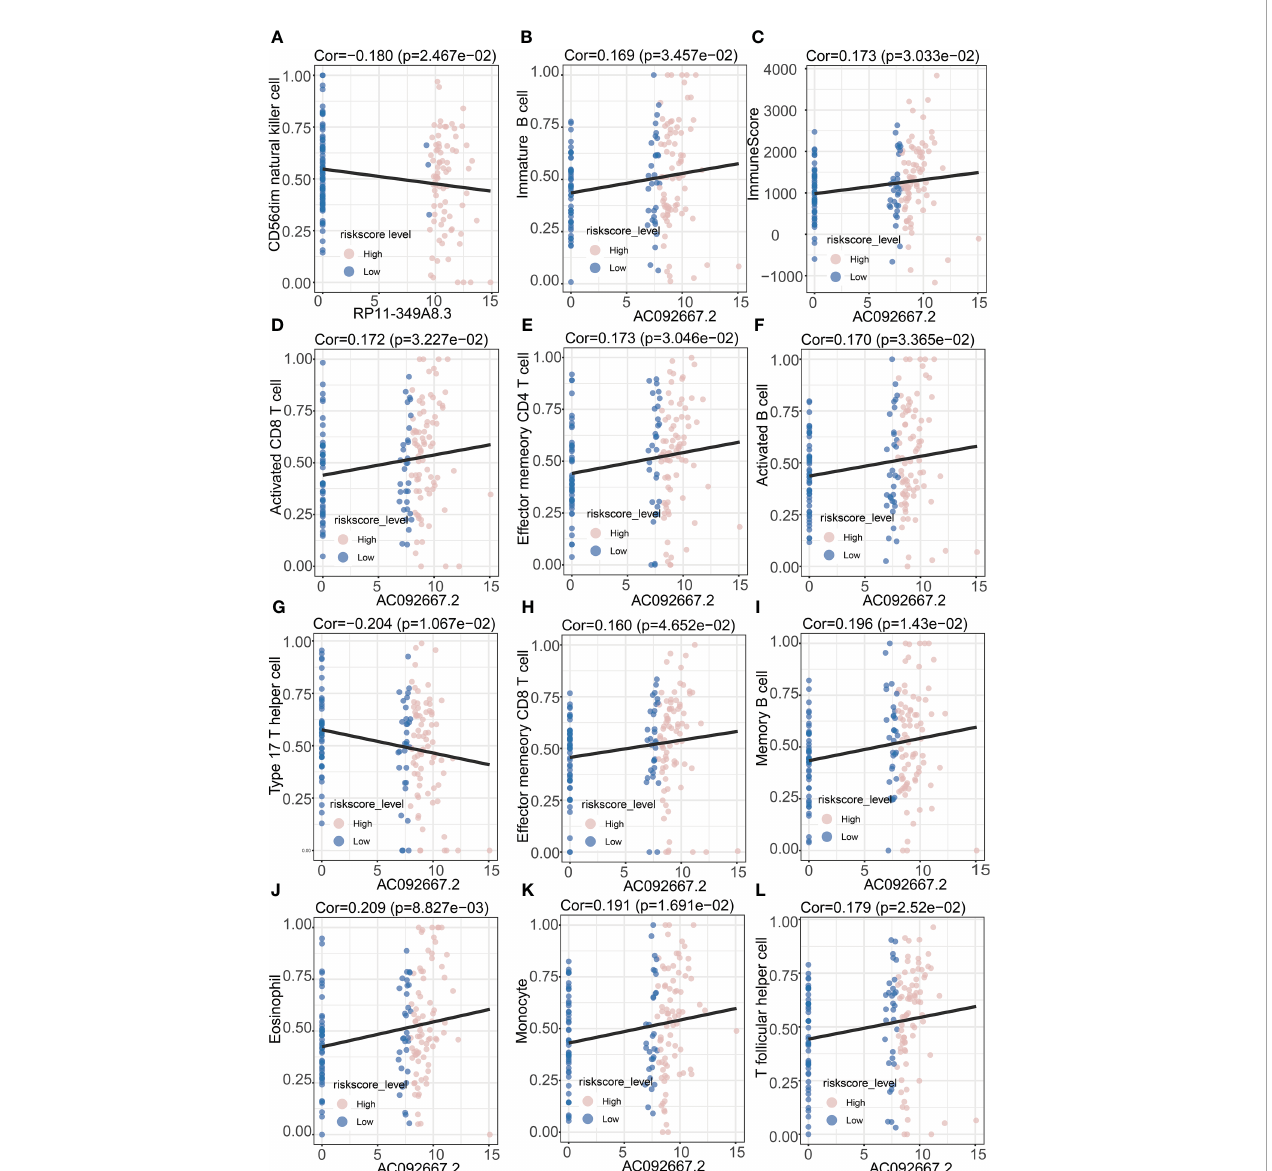
FIGURE 8 Correlation Analysis of prognosis-related lncRNAs and immune in fi ltrating cells. (A) Correlation analysis between RP11-349A8.3 and CD56dim natural killer cell. (B) Correlation analysis between AC092667.2 and Immature B cell. (C) Correlation analysis between AC092667.2 and ImmuneScore. (D) Correlation analysis between AC092667.2 and Activated CD8 T cell. (E) Correlation analysis between AC092667.2 and Effector memeory CD4 T cell. (F) Correlation analysis between AC092667.2 and Activated B cell. (G) Correlation analysis between AC092667.2 and Type 17 T helper cell. (H) Correlation analysis between AC092667.2 and Effector memeory CD8 T cell. (I) Correlation analysis between AC092667.2 and Memory B cell. (J) Correlation analysis between AC092667.2 and Eosinophil. (K) Correlation analysis between AC092667.2 and Monocyte. (L) Correlation analysis between AC092667.2 and T follicular helper